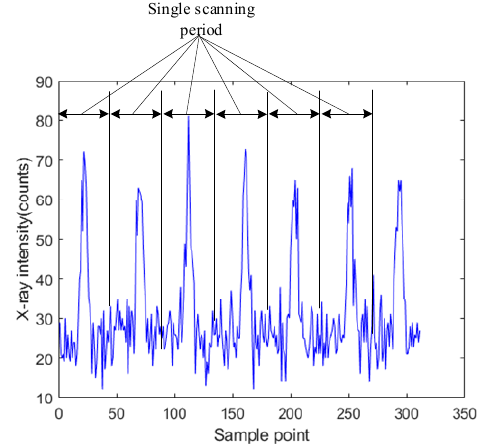
Figure 14. Schematic setup of the backscattered X-ray detection experiment.